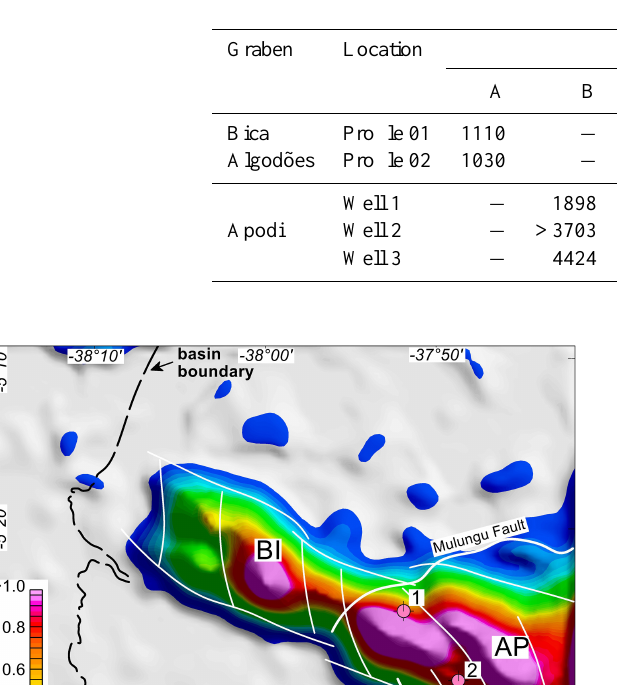
Table 1. Comparison between the depths to basement obtained from joint-inverted approach (A) and in exploratory wells (B) and those depths obtained by the 3-D gravity modeling using density contrast of − 270kgm − 3 (C) and − 200kgm − 3 (D) and the respective misfits.